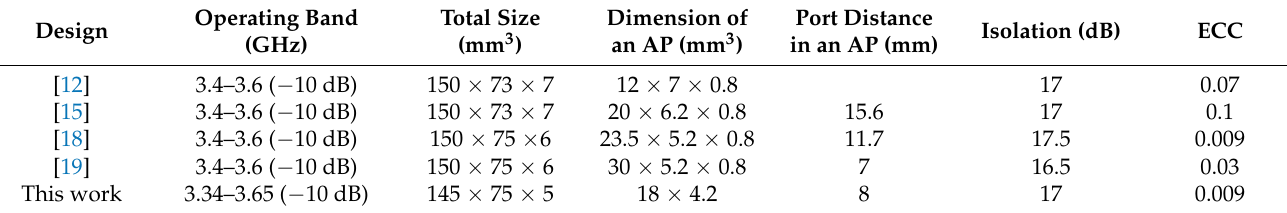
Table 1. Performance contrast between the proposed AP system with other state-of-arts.